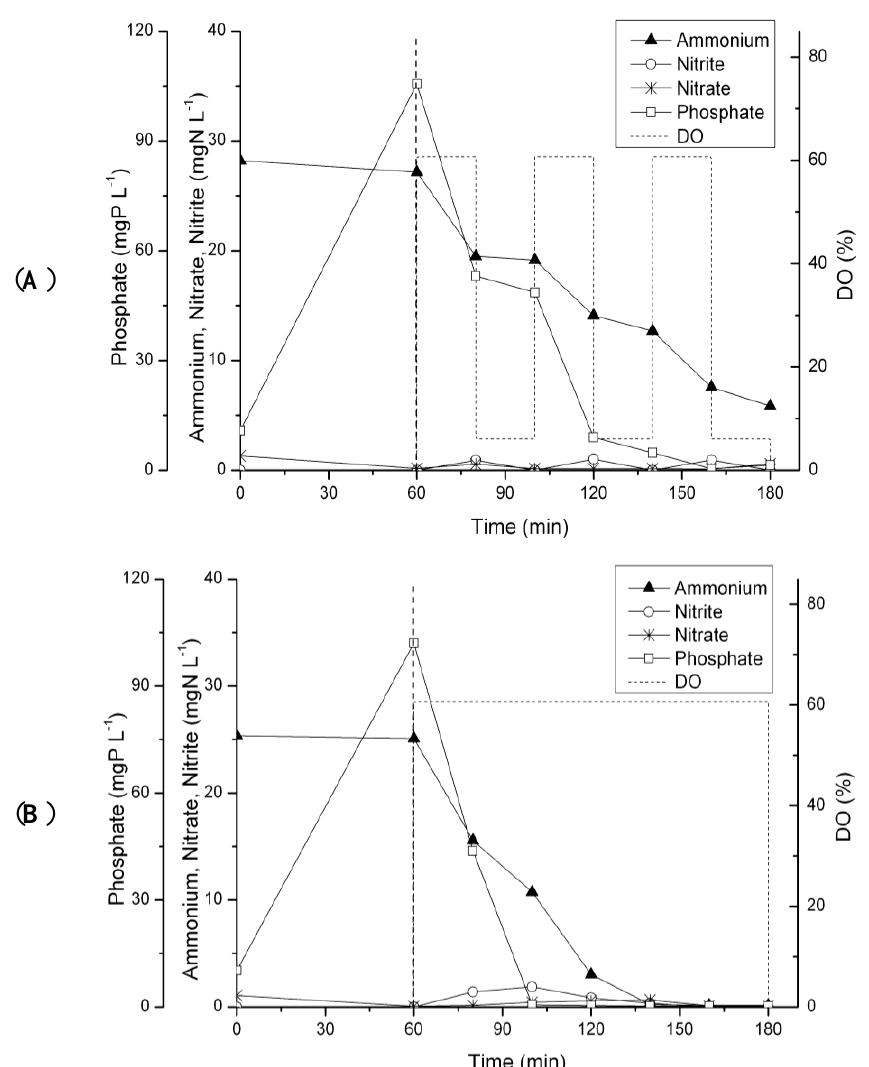
Figure 4. Concentrations of N and P compounds during one SBR cycle (at day 98) operated ( A ) with high-low DO strategy and ( B ) in a test cycle with uncontrolled full aeration. Concentrations at time 0 were calculated based on the effluent concentrations of the previous cycle and the influent concentrations. Aeration started after 60 min of plug-flow feeding (vertical dashed line). The dotted lines show schematically the aeration